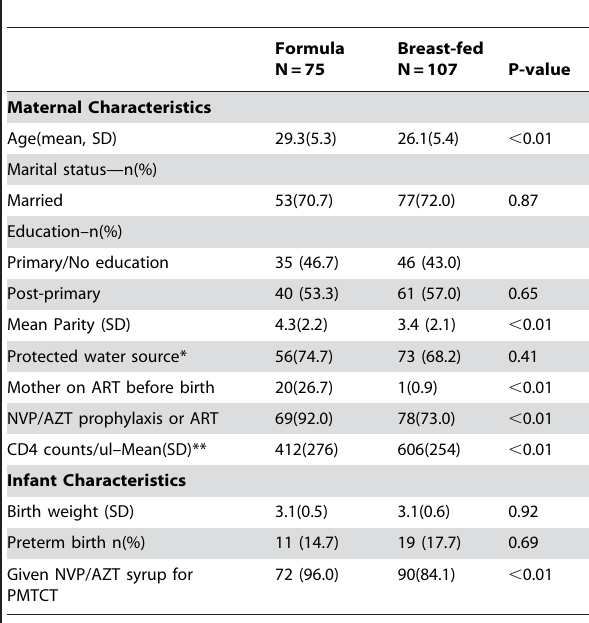
Table 1. Baseline Maternal and Infant